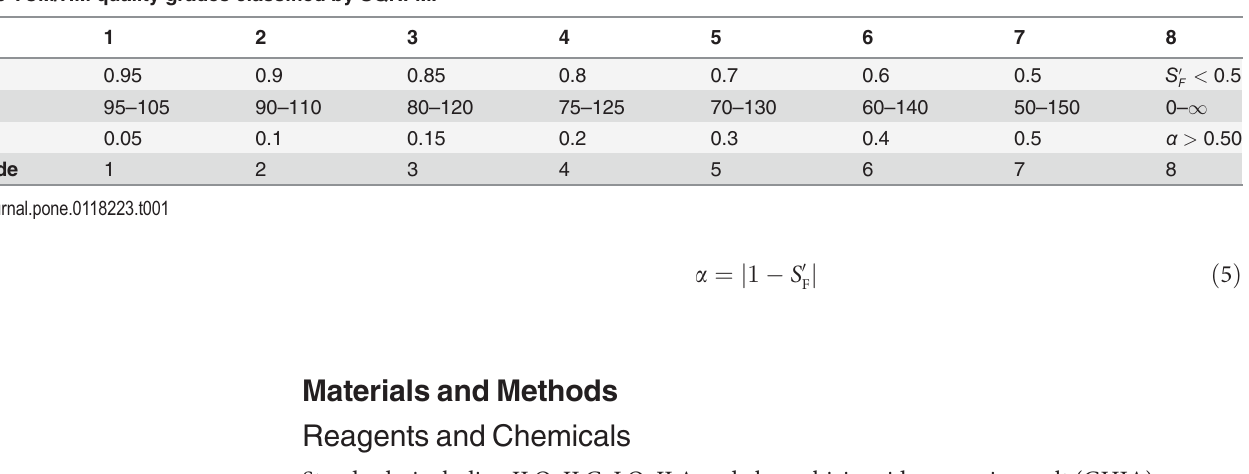
Table 1. The TCM/HM quality grades classi fi ed by